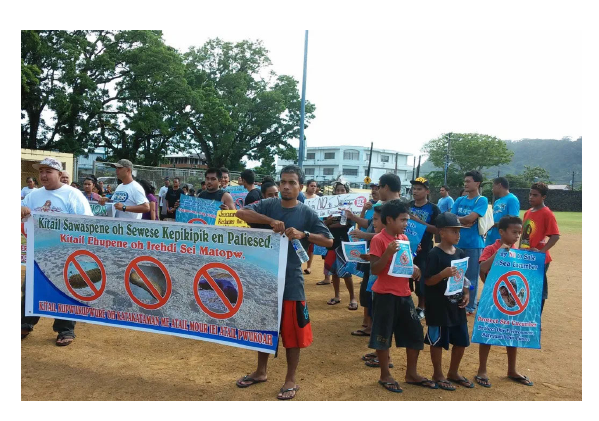
FIGURE 6 Citizens protest the sea cucumber trade in Pohnpei (source: “ Block Unsustainable Sea Cucumber Harvest, Pohnpei ” , Indiegogo Campaign). From Ferguson et al., 2022.